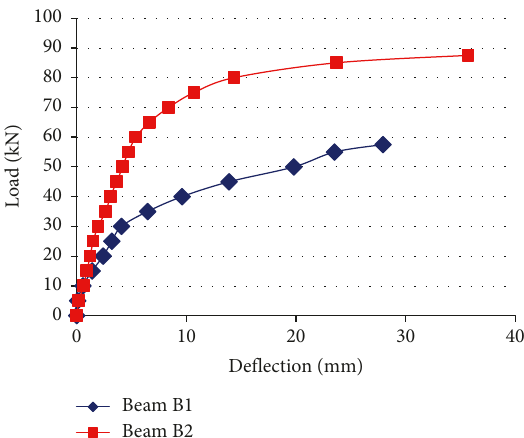
Figure 5: Effect of carbon fiber on load deflection response for beams having clear span � 1400mm.